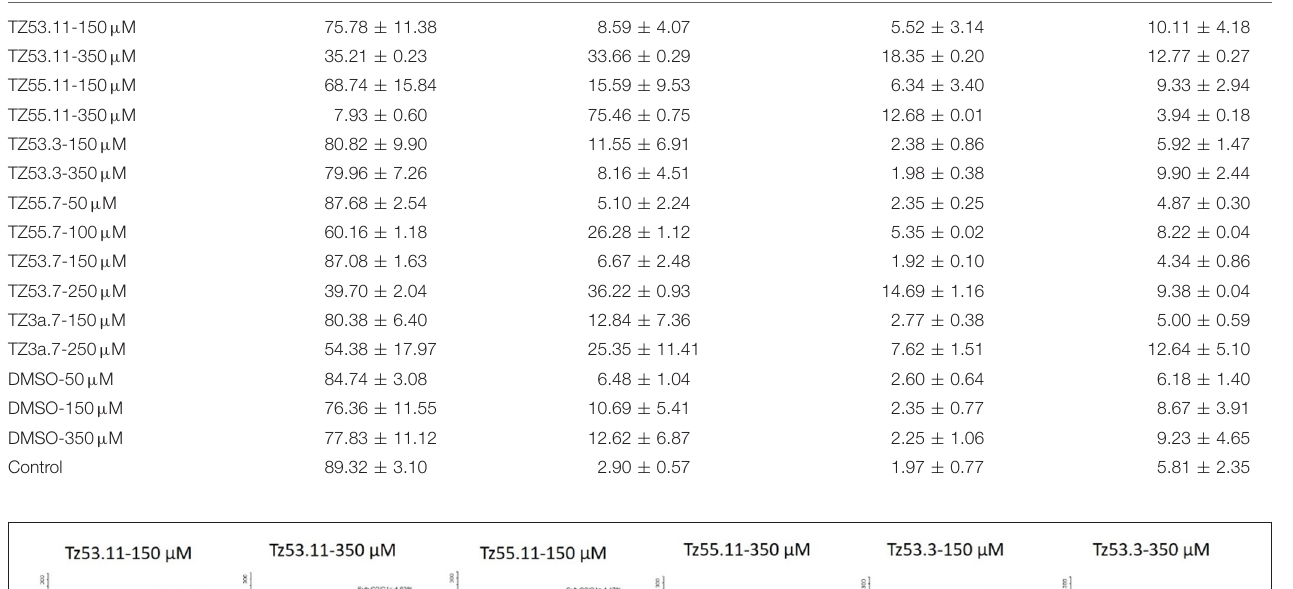
TABLE 3 | Viability of HT-29 human colorectal adenocarcinoma cell line using Annexin V/PI analysis. Compound-concentration